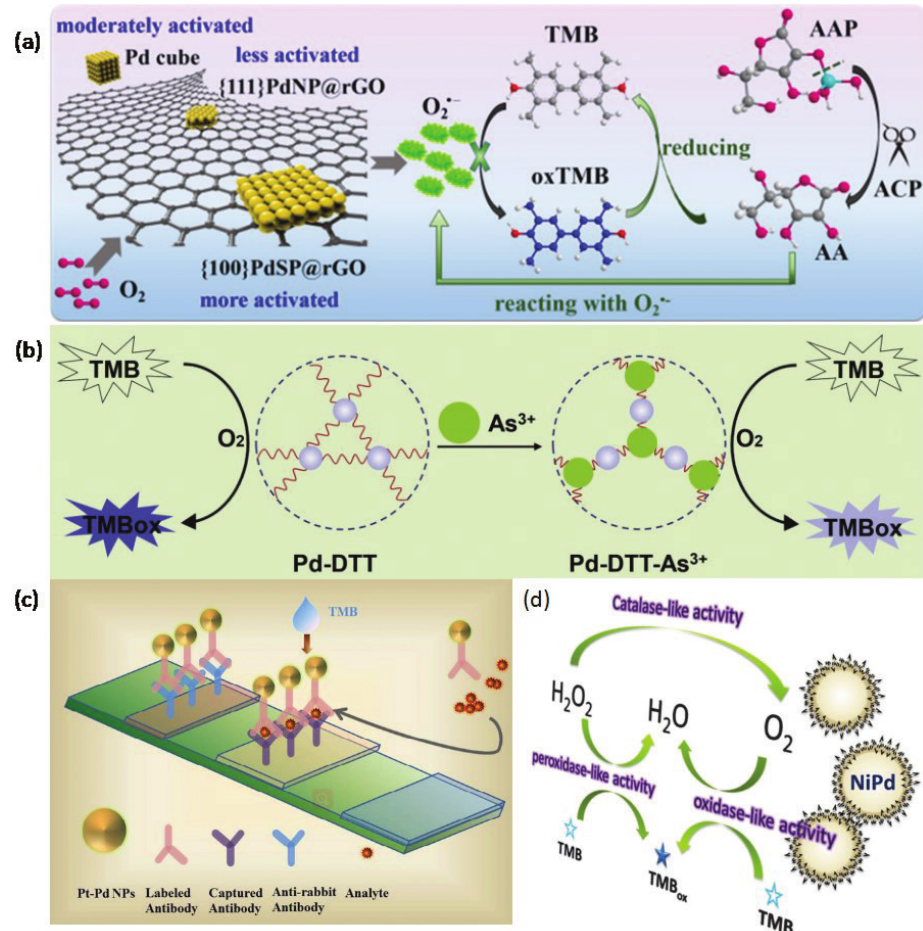
Figure 4: (a) Schematic diagram of oxidative activity of various Pd nanomaterials in the catalytic TMB oxidation. Reprinted image with permission from Ref. [73], Copyright 2019, American Chemical Society. (b) Schematic diagram of As 3+ mechanism of Pd-DTT colorimetric analysis of simulated activity inhibition of polylactic acid induced oxidase. Reprinted image with permission from Ref. [77], Copyright 2019, Elsevier B.V. (c) Schematic diagram of Pt-Pd NPs immunochromatography bands for the detection of p53 protein. Reprinted image with permission from Ref. [79], Copyright 2016, American Chemical Society. (d) Schematic diagram of the activity of NiPd-HNPs trienzyme simulation. Reprinted image with permission from Ref. [80], Copyright 2016, Royal Society of